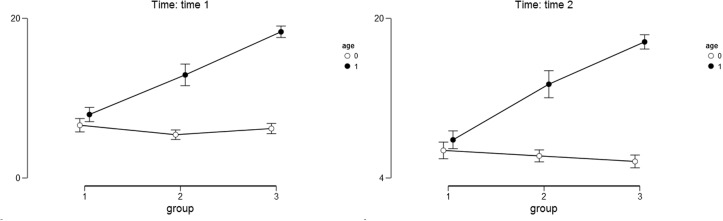
Descriptive statistics for optimism as the outcome variable. Age – 0 stands for younger children and 1 stands for older children. Group – 1 stands for control group; 2 stands for placebo group; 3 stands for narrative group. Error bars represent the 95% CI of a mean.